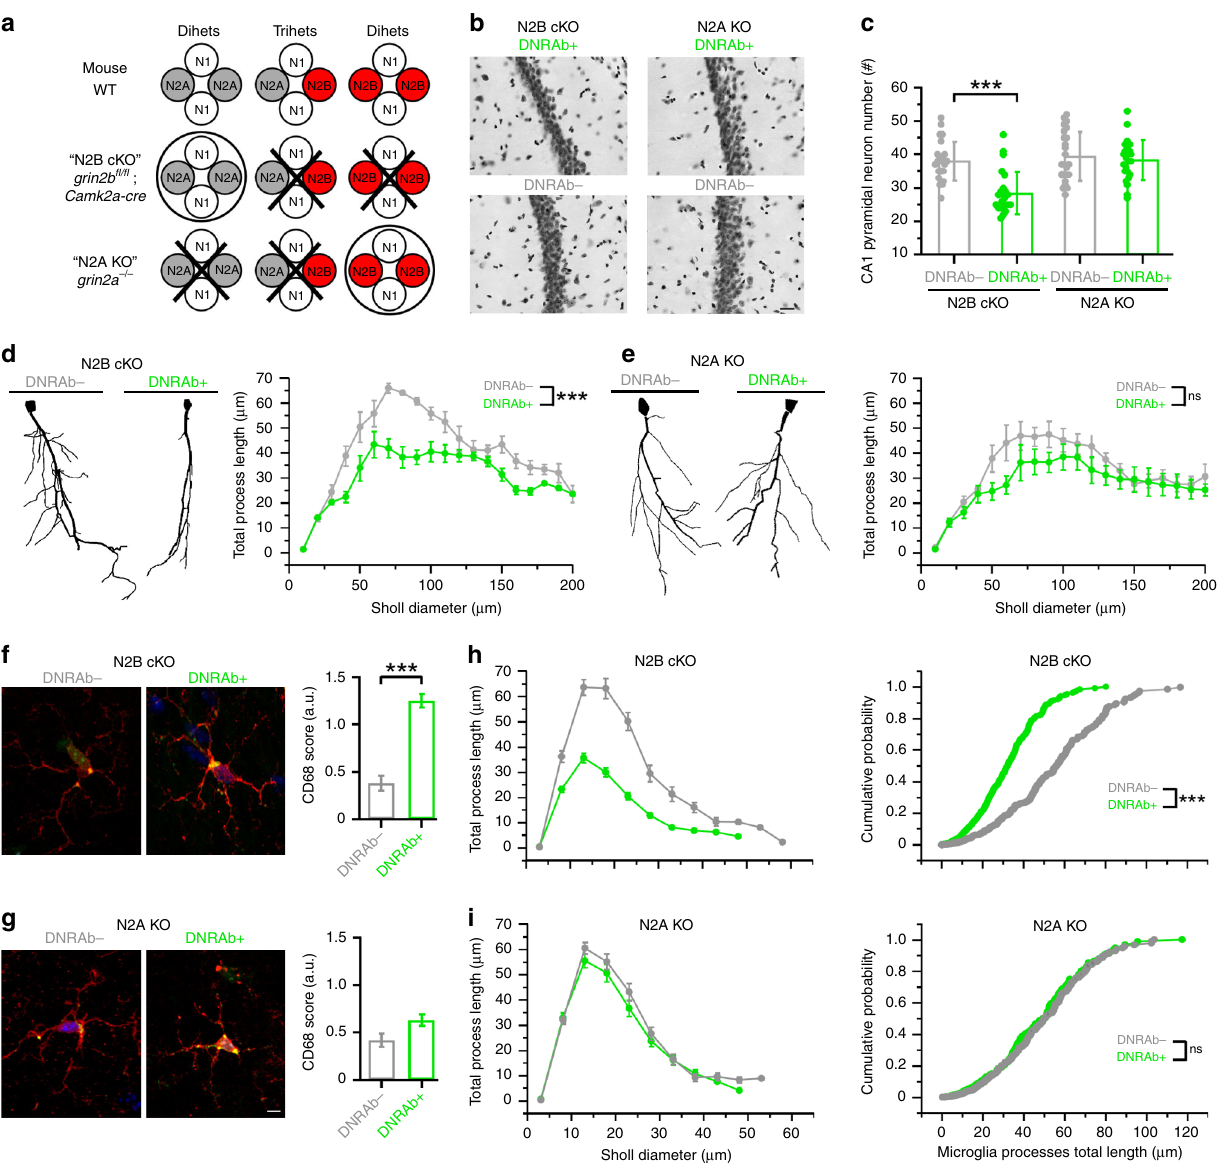
Fig. 4 DNRAbs induced neuronal loss and dendritic pruning in CA1 pyramidal neurons persist in mice-lacking GluN2B, but not in those lacking GluN2A. a Schematic of NMDAR composition expected in hippocampal pyramidal neurons in the various genetic backgrounds (Supplementary Fig. 2). b Micrographs of hippocampal CA1 neurons from DNRAb + or DNRAb − N2B cKO or N2A KO mice. Scale bar, 20 µ m. c Quanti fi cation of CA1 neurons (mean ± SEM, n = 24 sections per group). Each dot represents a CA1 pyramidal neuron fi eld counted using a standard unbiased stereological protocol (eight runs of systematic random sampling in three animals per group) ( ***p < 0.001, two-sided Mann – Whitney U test) (left to right, p = 0.0000156, 0.765). d , e Dendritic complexity of Golgi-stained neurons. Left, tracings of CA1 pyramidal neurons from N2B cKO ( d ) or N2A KO ( e ) mice. Right, Sholl analysis for N2B cKO ( d ) or N2A KO ( e ) mice (*** p < 0.001, two-sided Kolmogorov – Smirnov test for data converted to cumulative distribution function) (left to right, p = 2.754 × 10 − 16 , 0.61). Values at concentric rings are shown as mean ± SEM. For each group, 10 – 20 neurons per animal, 4 animals per group. f , g Representative images of microglia from N2B cKO ( a ) or N2A KO ( b ) mice. Microglia are labeled with antibody to Iba1 (red, Alexa 594) and to CD68 (green, Alexa-488). Scale (white bar): 5 µ m. Right panels, quanti fi cation of CD68 + score (mean ± SEM) (*** p < 0.001, Kruskal – Wallis ANOVA test) (left to right, p = 0.00000000222, 0.0793) (see Supplementary Methods). Three animals per group; number of quanti fi ed microglia: N2B cKO, DNRAb − ( n = 42), DNRAb + ( n = 87), N2A KO, DNRAb − ( n = 57), DNRAb + ( n = 58). h , i Microglia process complexity and length. Left panels, Sholl analysis of process length of microglia from N2B cKO ( h ) or N2A KO ( i ) mice. Right panels, cumulative probability distribution curves of microglia process length from N2B cKO ( h ) or N2A KO ( i ) (*** p < 0.001, two-sided Kolmogorov – Smirnov test) (top to bottom, p = 7.16 × 10 − 8 , 0.999). Three animals per group; number of quanti fi ed microglia: N2B cKO, DNRAb − ( n = 33), DNRAb + ( n = 34); N2A KO, DNRAb − ( n = 39), DNRAb + ( n = (Fig. 4f, right panel) and diminution of process complexity (Fig. 4h, activation 19 . We therefore characterized microglia in DNRAb + left panel), and process length (Fig. 4h, right panel) over concentric and DNRAb − mice in the various genetic backgrounds (Fig. 4f – i). Sholl diameters. These results are consistent with microglia For the N2B cKO background, and in comparison with its activation and parallel what is observed in wild-type mice 19 . In control, DNRAb + mice showed enhanced expression of CD68